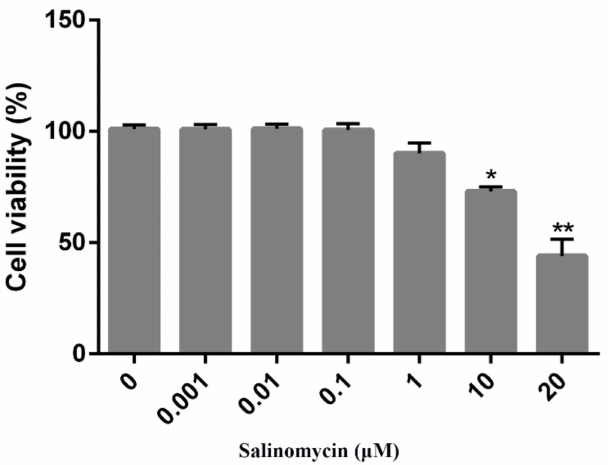
Figure 1. Cytotoxicity of salinomycin in Vero cells. Vero cells treated with salinomycin at indicated concentrations for 24 h at 37 ◦ C or incubated with the culture medium containing DMSO as a control and subjected to CCK8 assay to detect cell viability. Cell viability ranged from 0% to 100%. Data are expressed as three independent experiments. * p < 0.05. ** p <